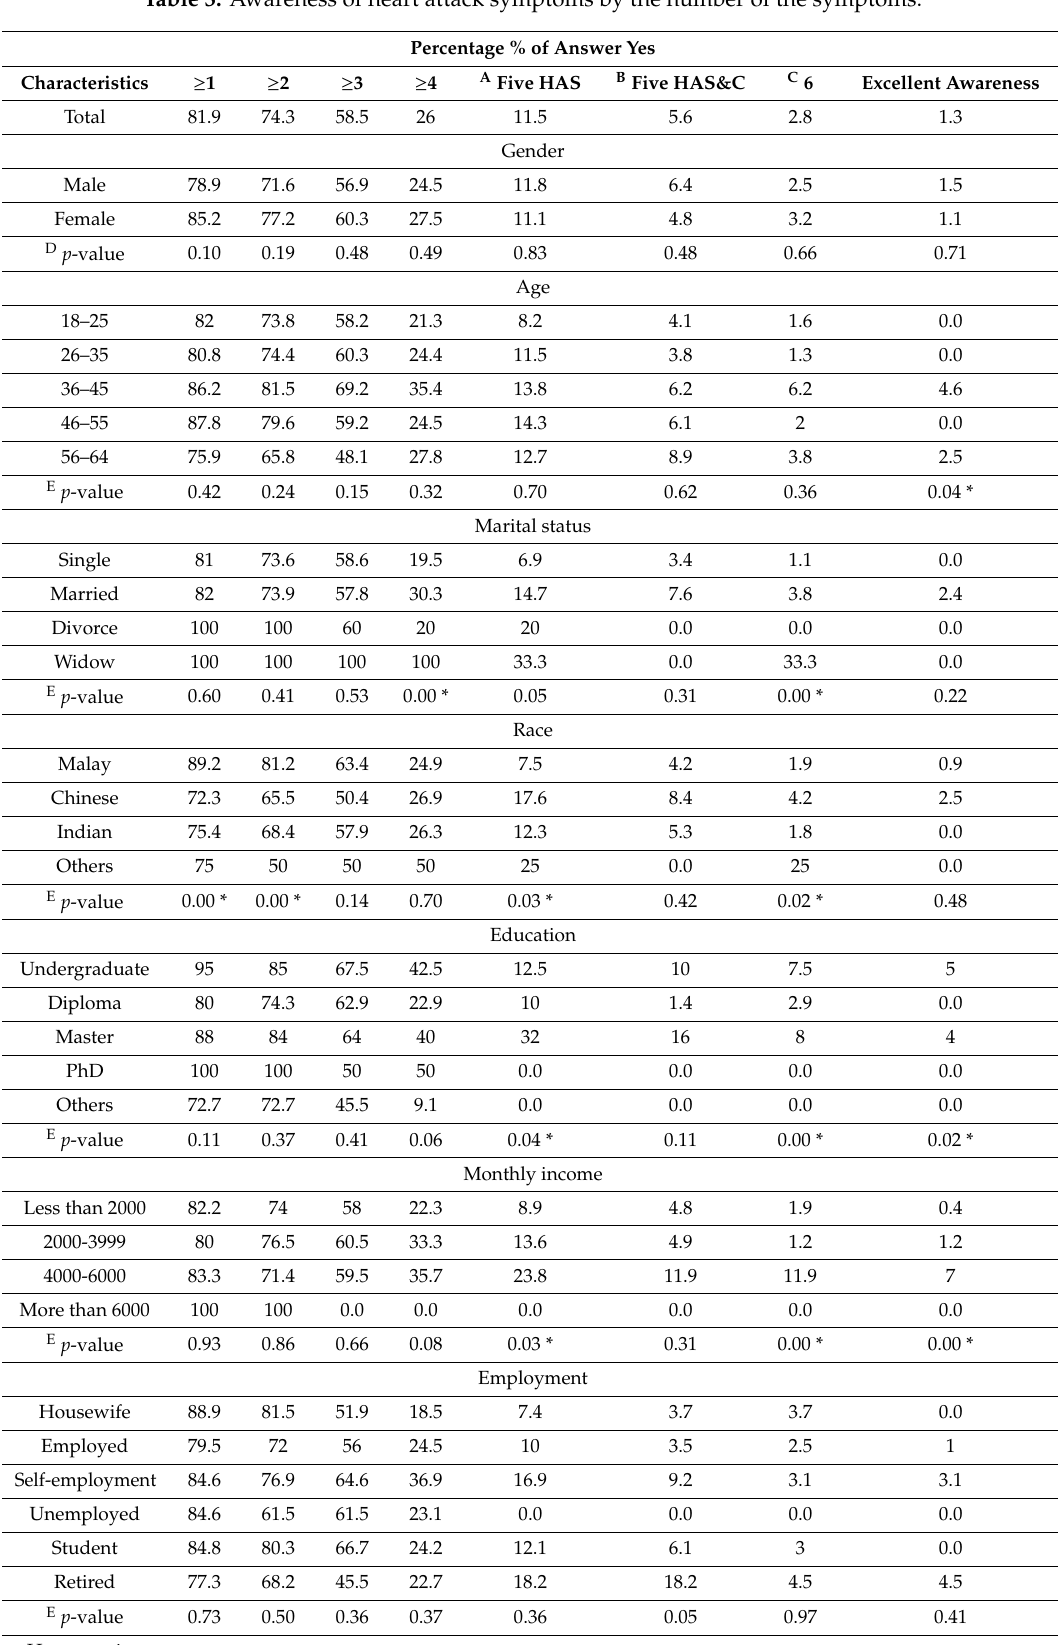
Table 3. Awareness of heart attack symptoms by the number of the